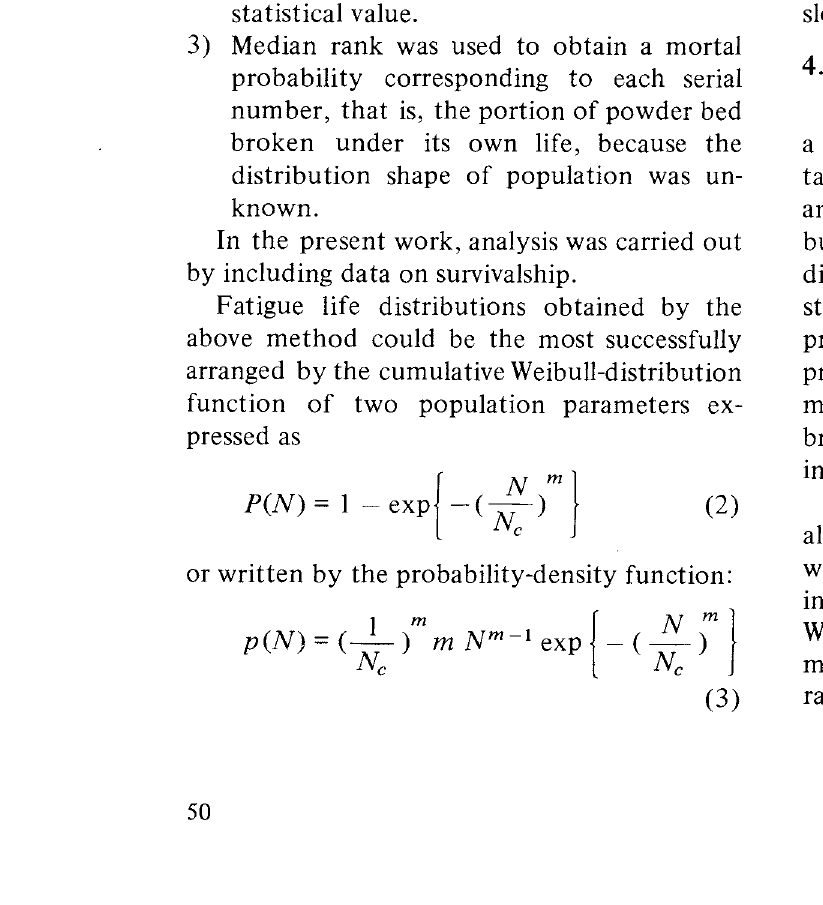
Fig. 4 Relation between stress ratio and fatigue life (S-N